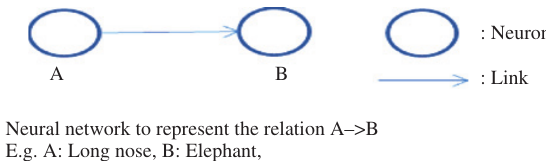
Figure 1: Using Components of ANN to Represent Logical